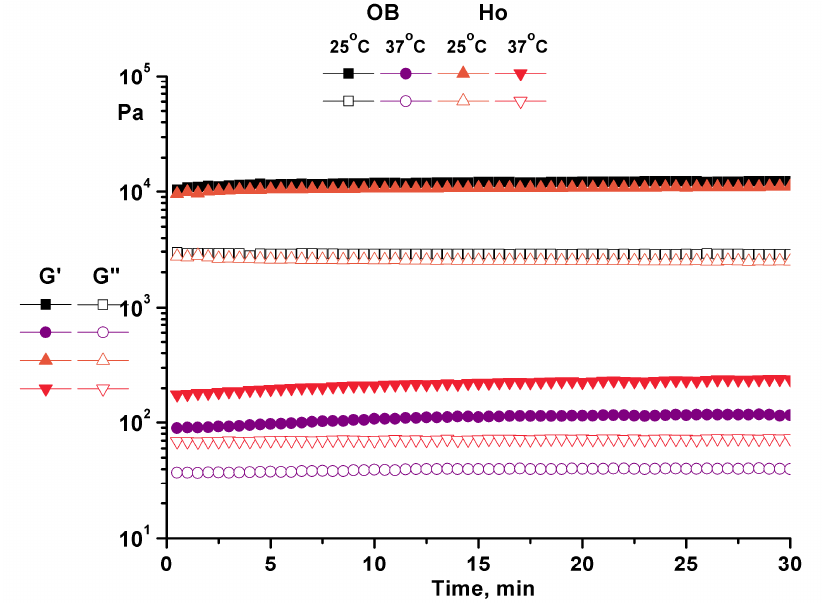
Figure 5. Time test for analyzed ointment. OB—ointment base, Ap—ointment base + apilarnil, Pr—ointment base + propolis, Ho—ointment base + honey, Ta—ointment base + mixture of bee products.